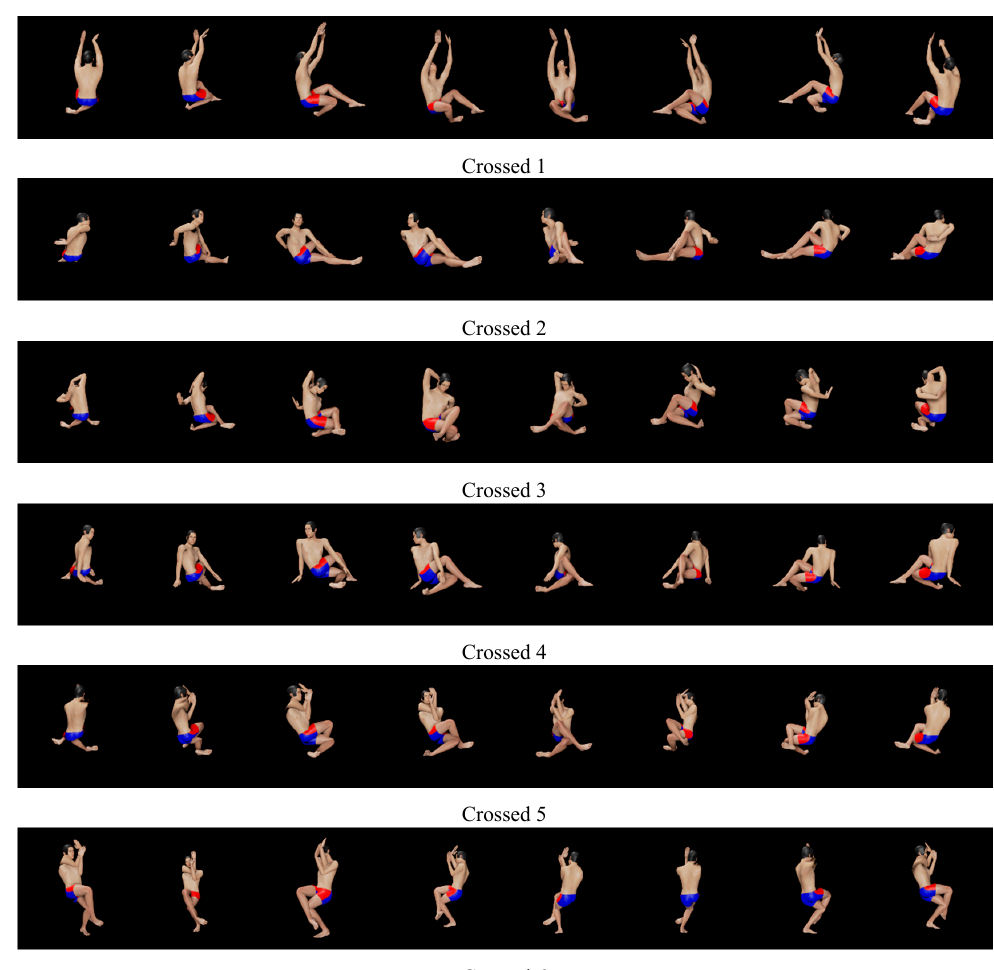
Figure 6. Six crossed poses.